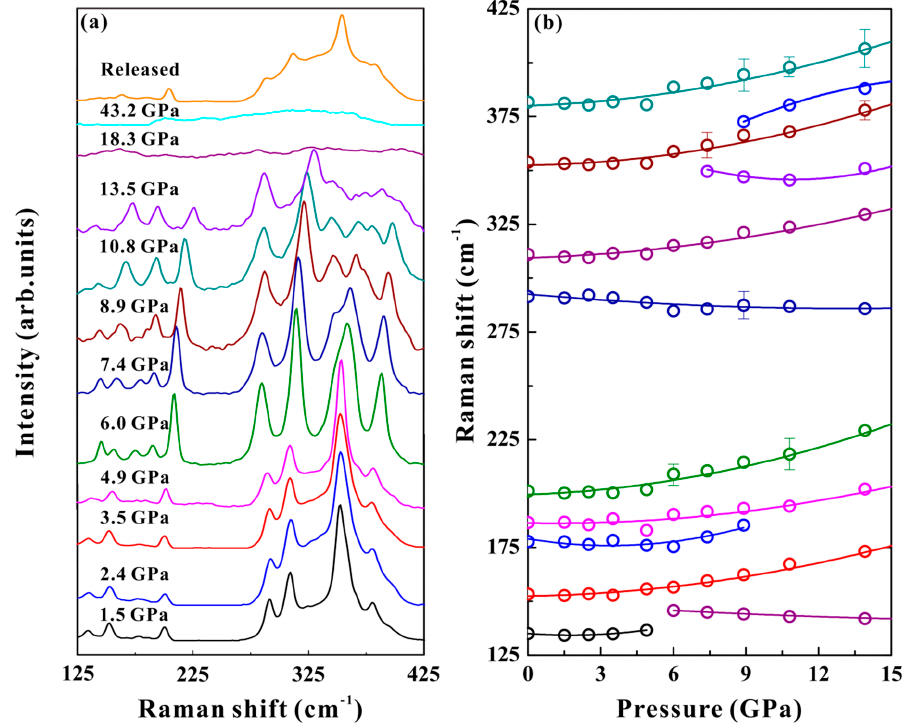
Figure 4. ( a ) Raman spectra of orpiment at selected pressures under hydrostatic condition ( λ = 514 nm, T = 300 K). ( b ) Raman mode frequency evolution against pressure.